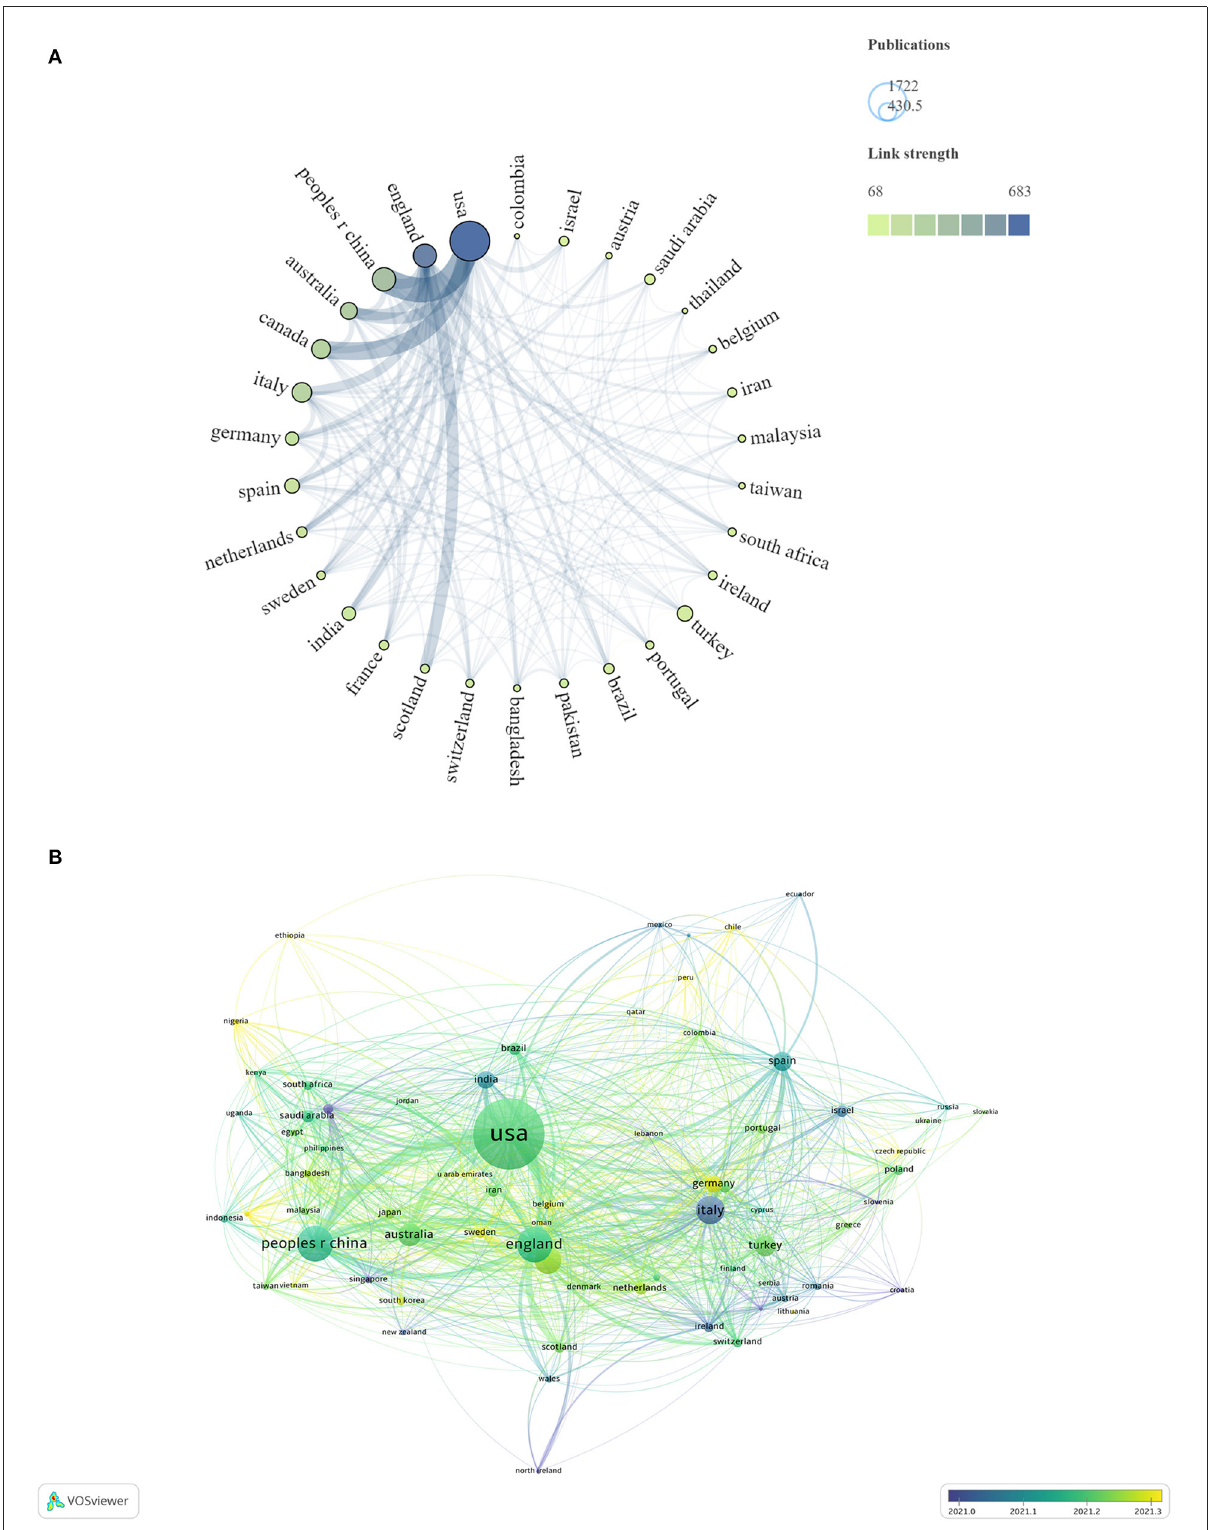
FIGURE2 Geographical distribution in the past 3 years (A) . The size of the circle displays the number of publications, and the thickness of links represents cooperation strength between countries. Overlay Geographical visualization was based on publication-weights and average publication year scores (B)